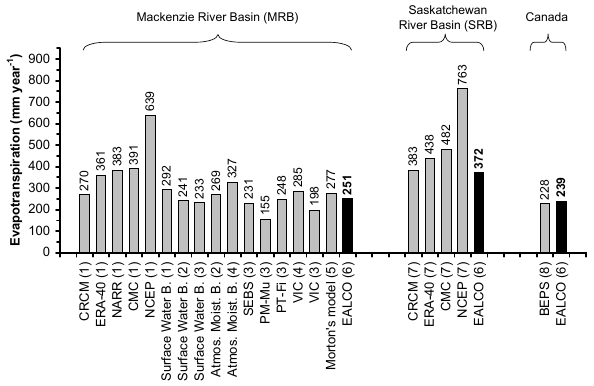
Fig. 15. Comparison of evapotranspiration estimates from differ- ent studies. Data source followed by the study period: (1) Szeto et